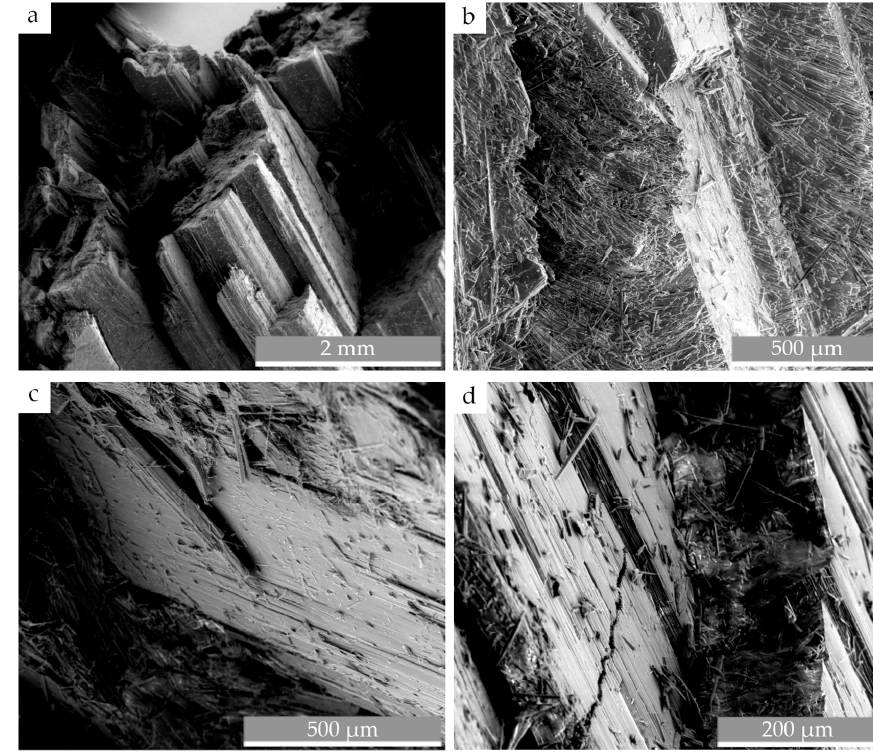
Figure 6. SE images of the asbestiform arrangement of fibers, with some randomly oriented regions at different magnifications. ( a ) Parallel fibers in a columnar arrangement. ( b ) Parallel and randomly oriented fibers. ( c ) Fibers that appear to be detaching from the bulk. ( d ) Fracture area with